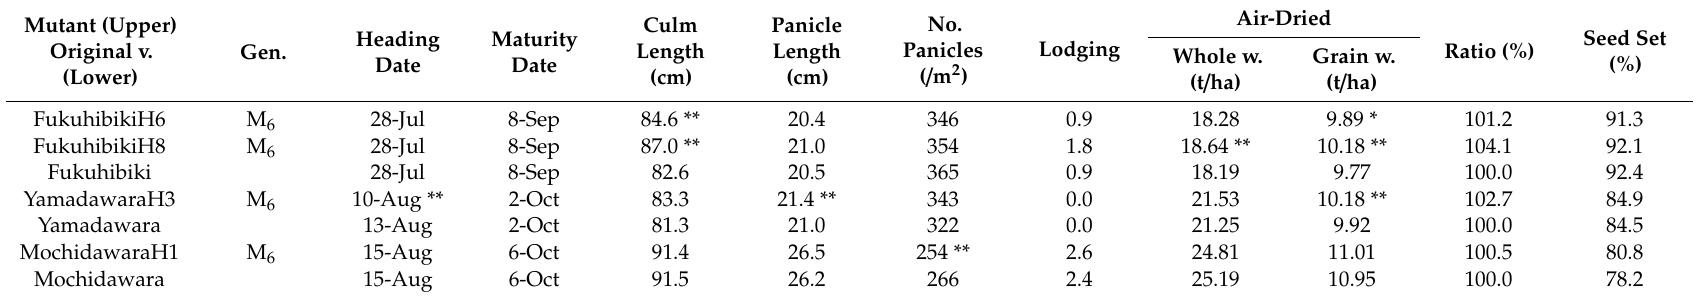
Table 3. Yield trial of mutants in paddy fields in Ibaraki, Japan in